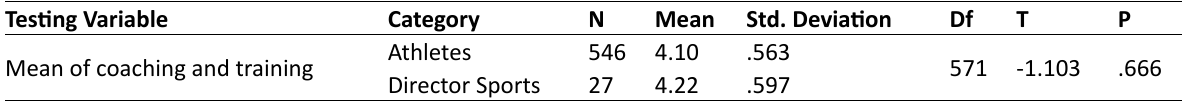
Table 6. Showing difference between responses of athletes and director sport regarding the effect of Coaching and training as factor upon sport performance of the athletes both in public and in private sector universities of KP,